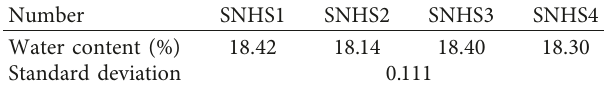
Table 5: Percentage of particles larger than 2 mm and smaller than